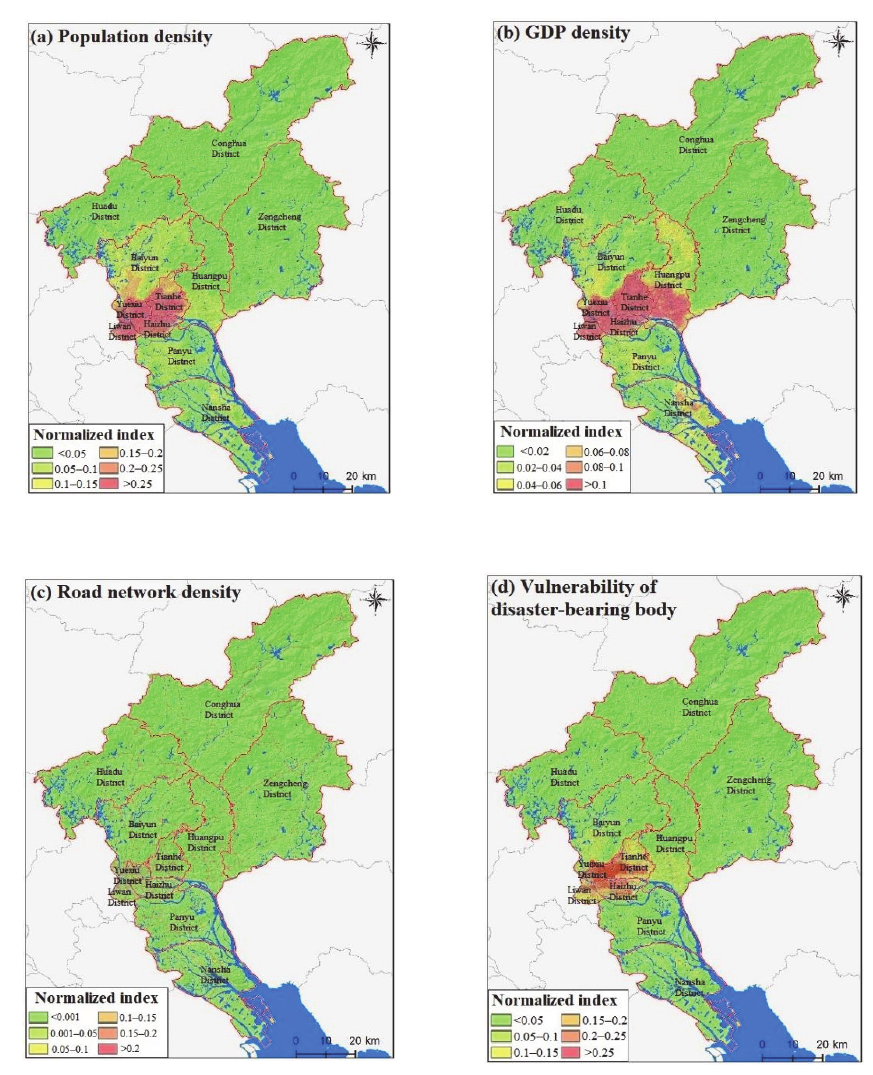
Figure 9. Sub-indicators and comprehensive evaluation of the vulnerability of the disaster-bearing body: ( a ) population density; ( b ) GDP density; ( c ) road network density; ( d ) vulnerability of the disaster-bearing body.